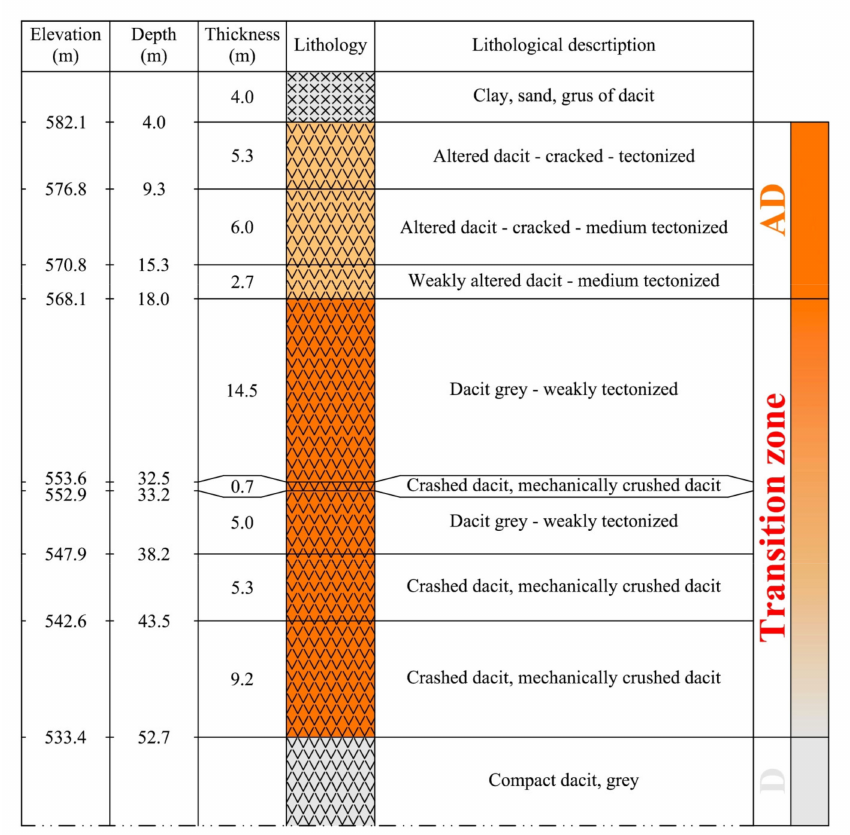
Figure 1. Lithological column of the exploration